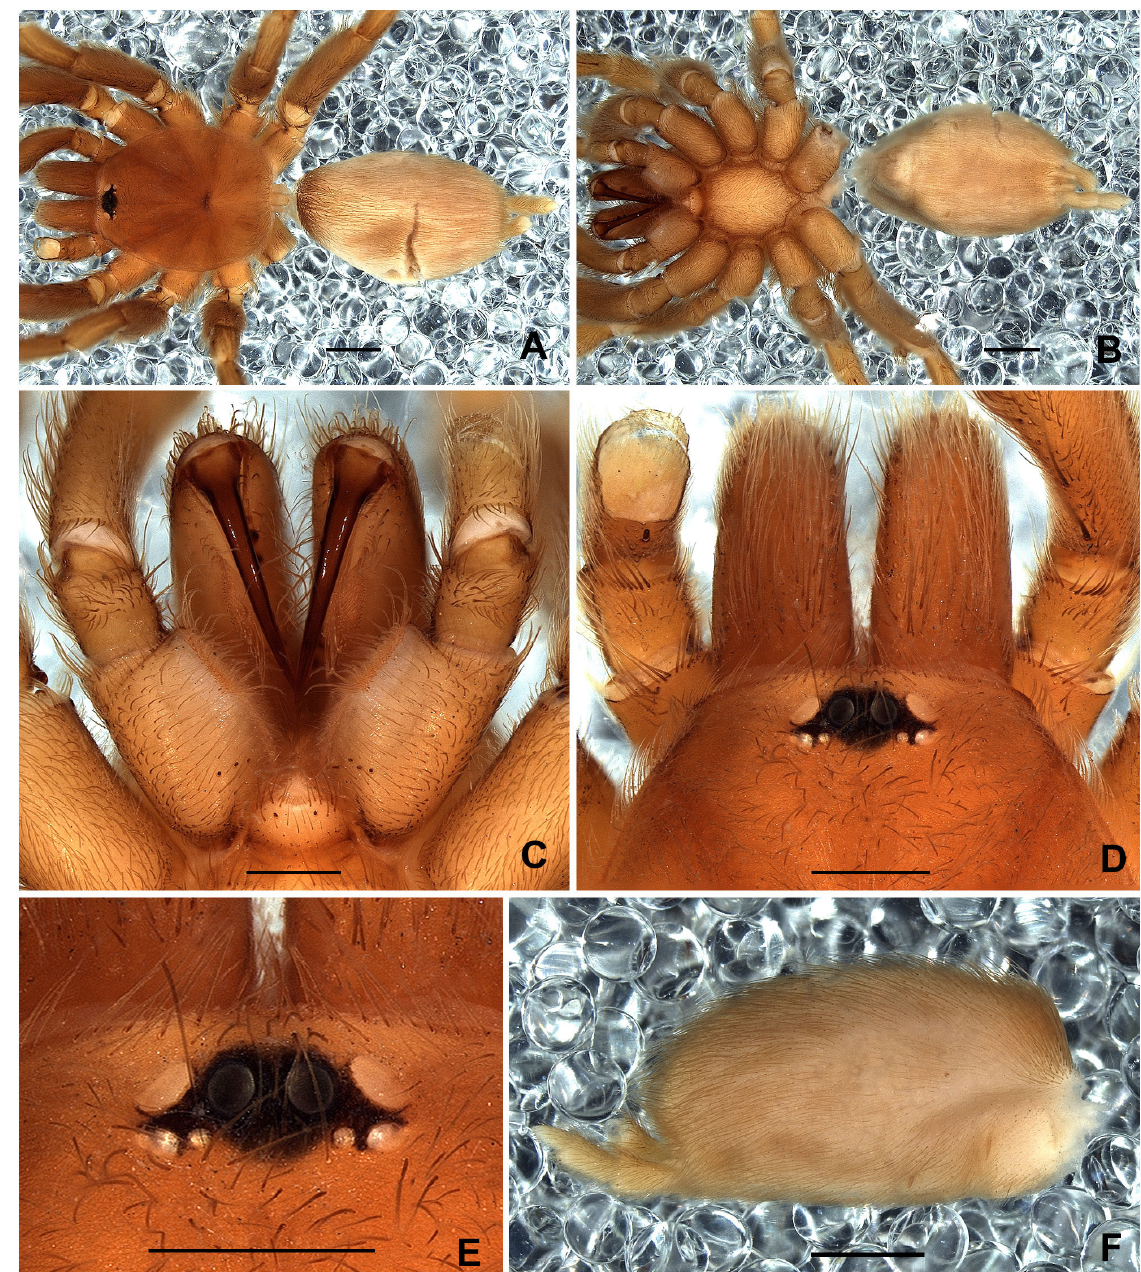
Fig. 1. Ammonius pupulus Thorell, 1899, holotype, ♂ (NHRS-GULI37848). A . Habitus dorsal. B . Habitus ventral. C . Maxillae and labium, ventral view. D–E . Eye group. D . Dorsal view. E . Detail of the eye arrangement. F . Abdomen, lateral view. Scale bars: A–B, F = 1 mm; C–E = 0.5